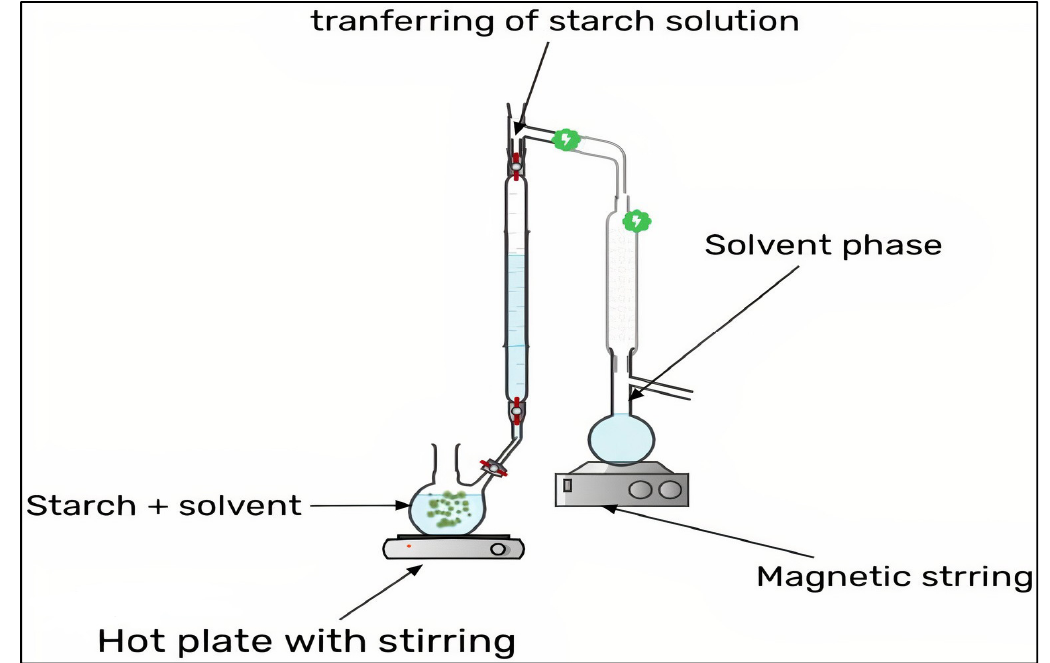
Figure 4. Nano-precipitation method of SNPs.